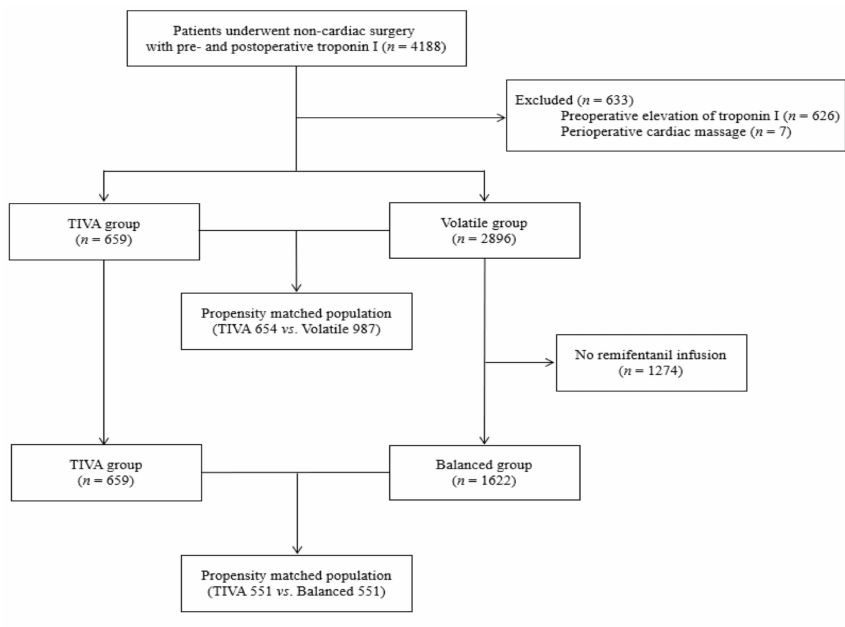
Figure 1. Flowchart of patients. TIVA indicates total intravenous